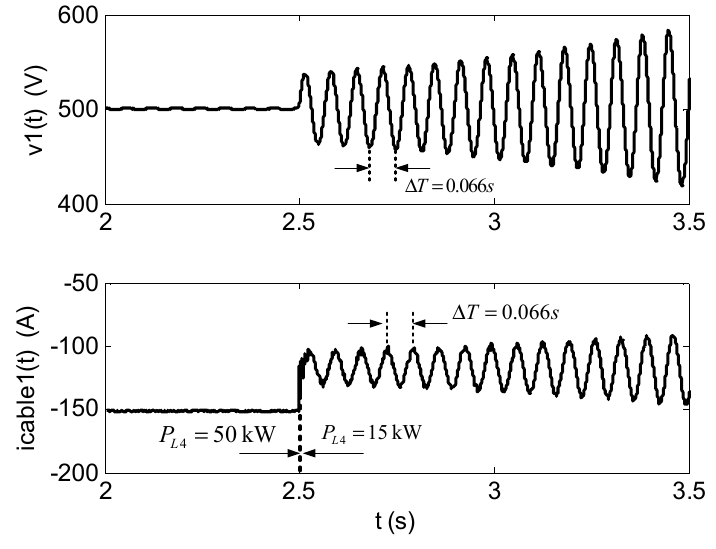
Figure 15. Comparison between